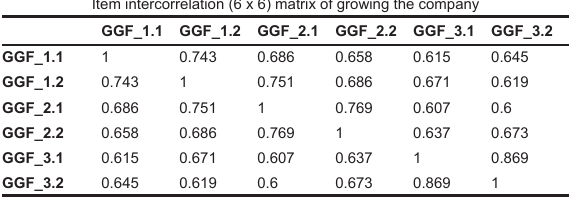
TABLE 3 Item intercorrelation (6 x 6) matrix of growing the company